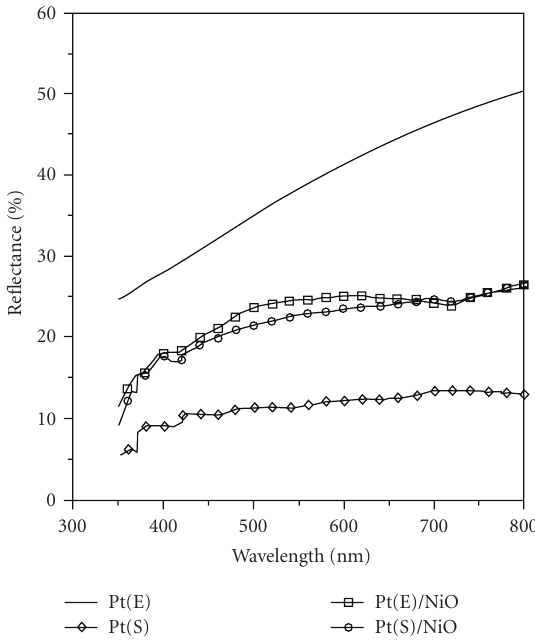
Figure 4: Variations in reflectance with the wavelength of the light for counter electrodes of Pt(E), Pt(S), Pt(E)/NiO, and